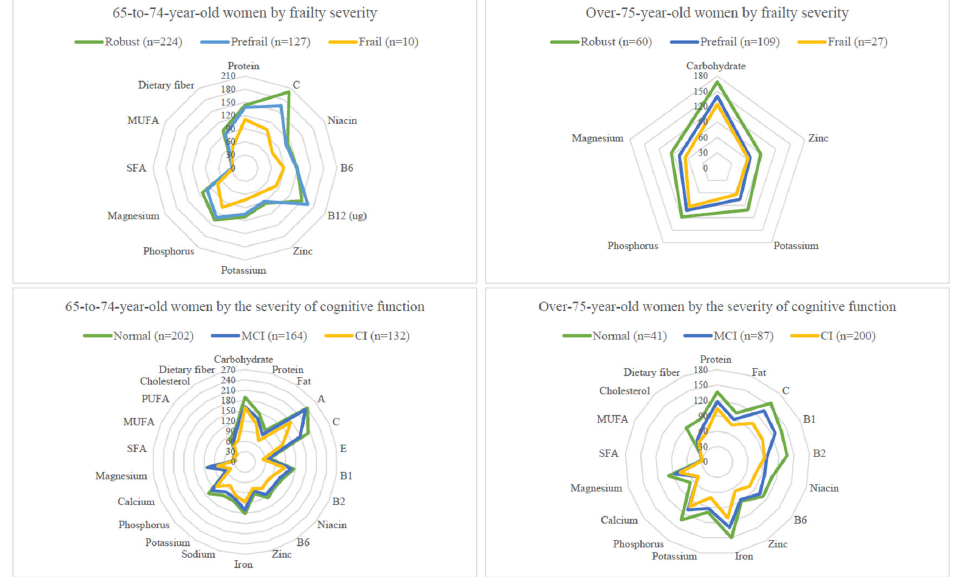
Figure 2. Comparing nutrient intake levels (presented as % RDA) across geriatric syndrome sub ‐ groups in women. Top: Total energy and nutrients intakes (presented as % RDA) by three frailty subgroups and by two age groups in women. Bottom: Total energy and nutrients intakes (presented as % RDA) by three CI subgroups and by two age groups in women. The trend test was performed by using the general linear model to test whether the mean of each nutrient variable has an ordered relationship across either the three frailty subgroups or three CI subgroups when age was adjusted.